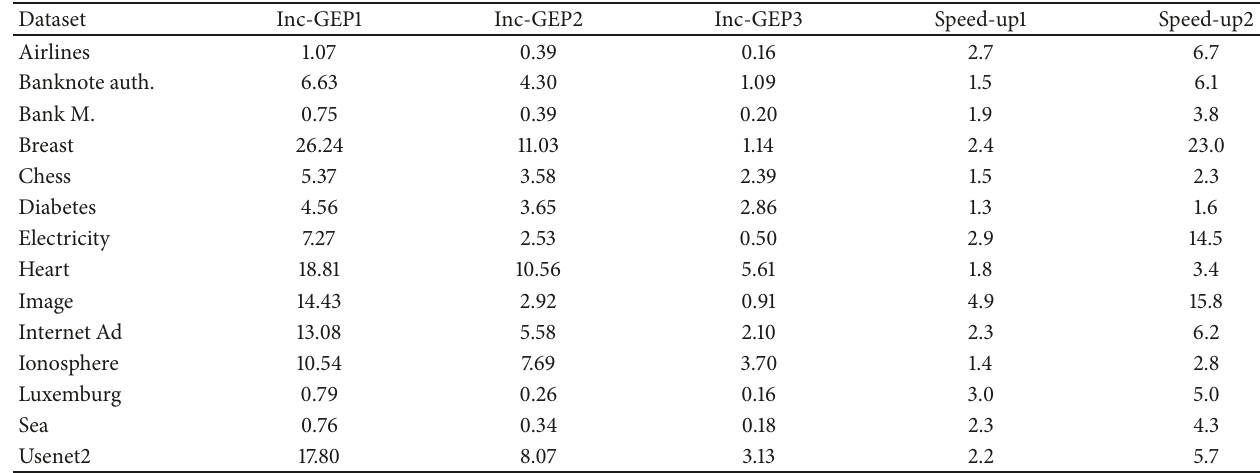
Table 8: Mean computation times (seconds per 100